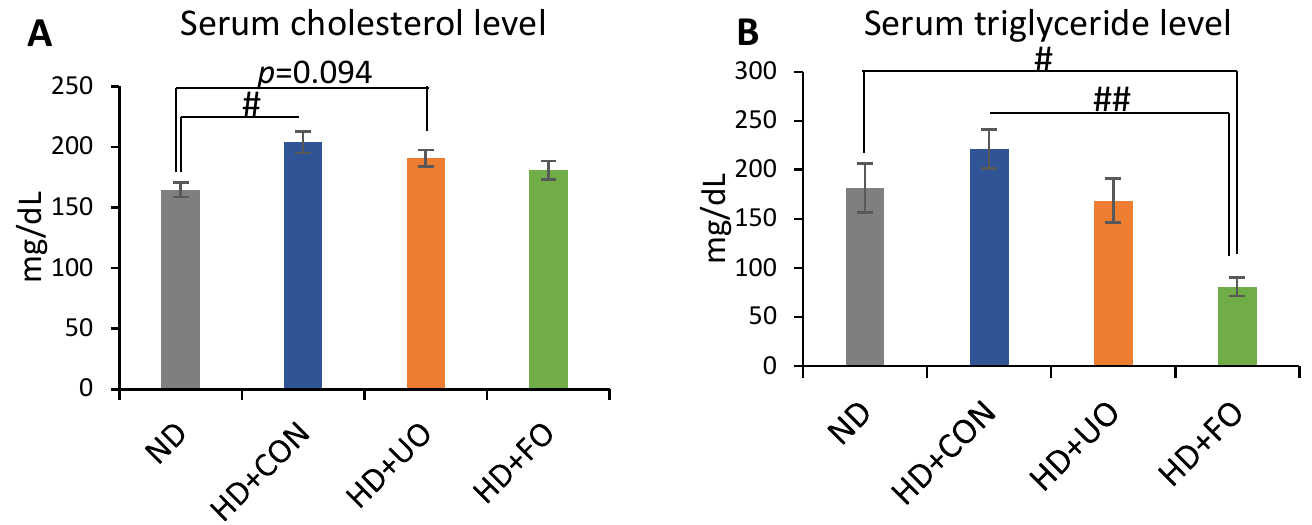
Figure 4. Lipid profile in the serum (cholesterol and triglyceride). Serum cholesterol ( A ) and serum triglyceride ( B ) levels of mice fed each experimental diet for 3 weeks. Data are represented as mean ± SEM (ND, HD + CON, HD + UO: n = 6, HD + FO: n = 7) # p < 0.05, ## p < 0.01 evaluated using the Kruskal–Wallis test with Dunn’s post-hoc test.